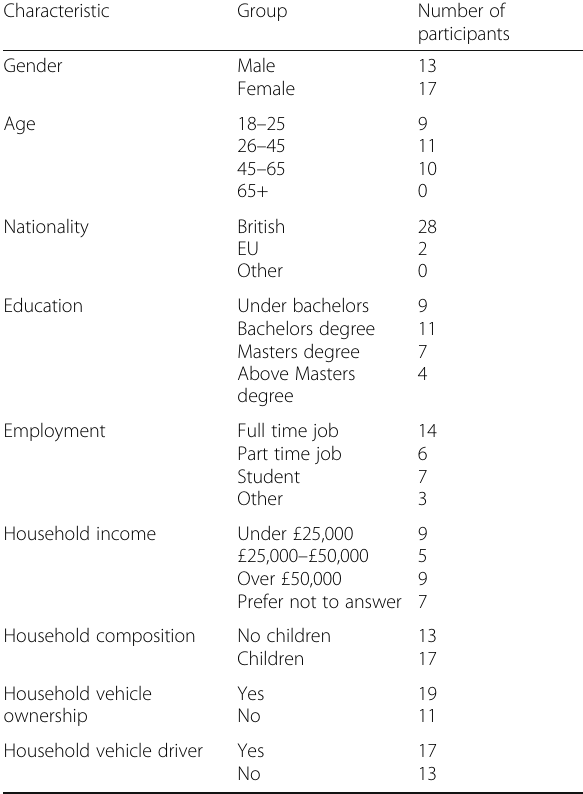
Table 2 Characteristics of